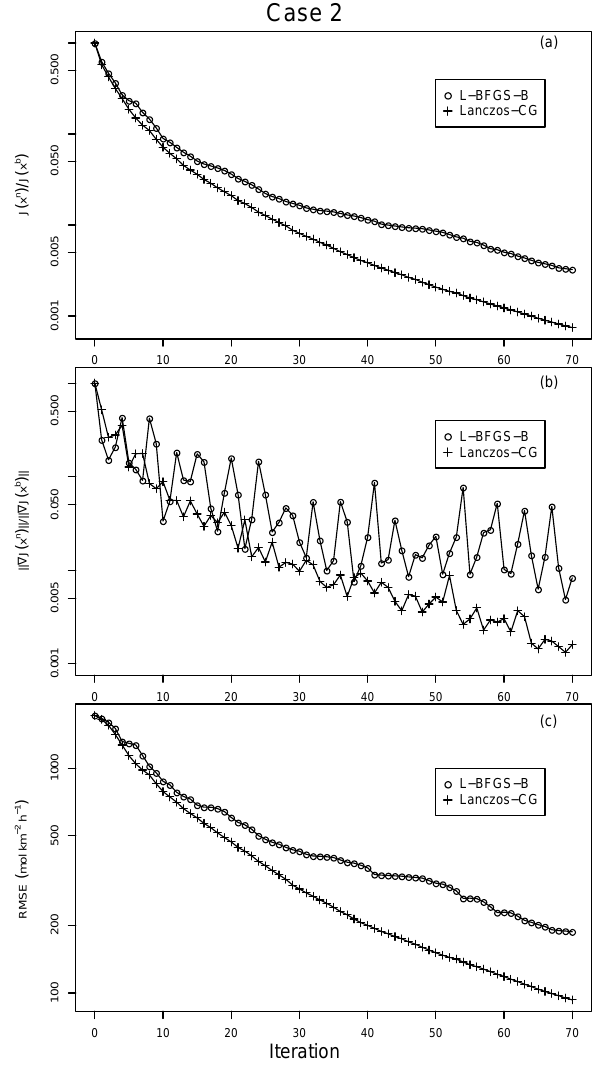
Figure 15. Same as Fig. 13 but for the inverse modeling experiment (Case